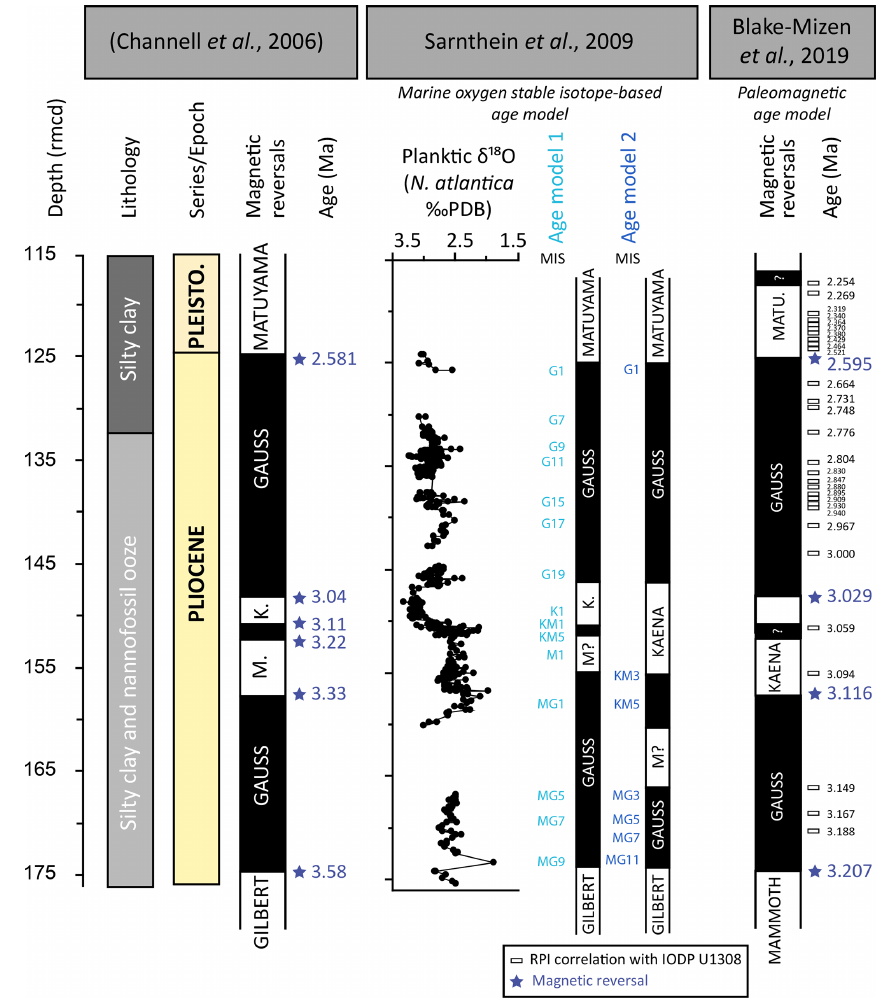
Figure 2. Age models at IODP Site U1307. Magnetostratigraphy and lithology of IODP Site U1307 from Channell et al. (2006). Stable oxygen isotope data based on the planktic foraminifer Neogloboquadrina atlantica and two proposed age models from Sarnthein et al. (2009). The most recent age model is based on magnetic reversals and a paleointensity record tuned to IODP Site U1308 (Blake-Mizen et al., 2019). M: Mammoth Subchron; K: Kaena Subchron; MIS: Marine Isotope Stage; RPI: relative